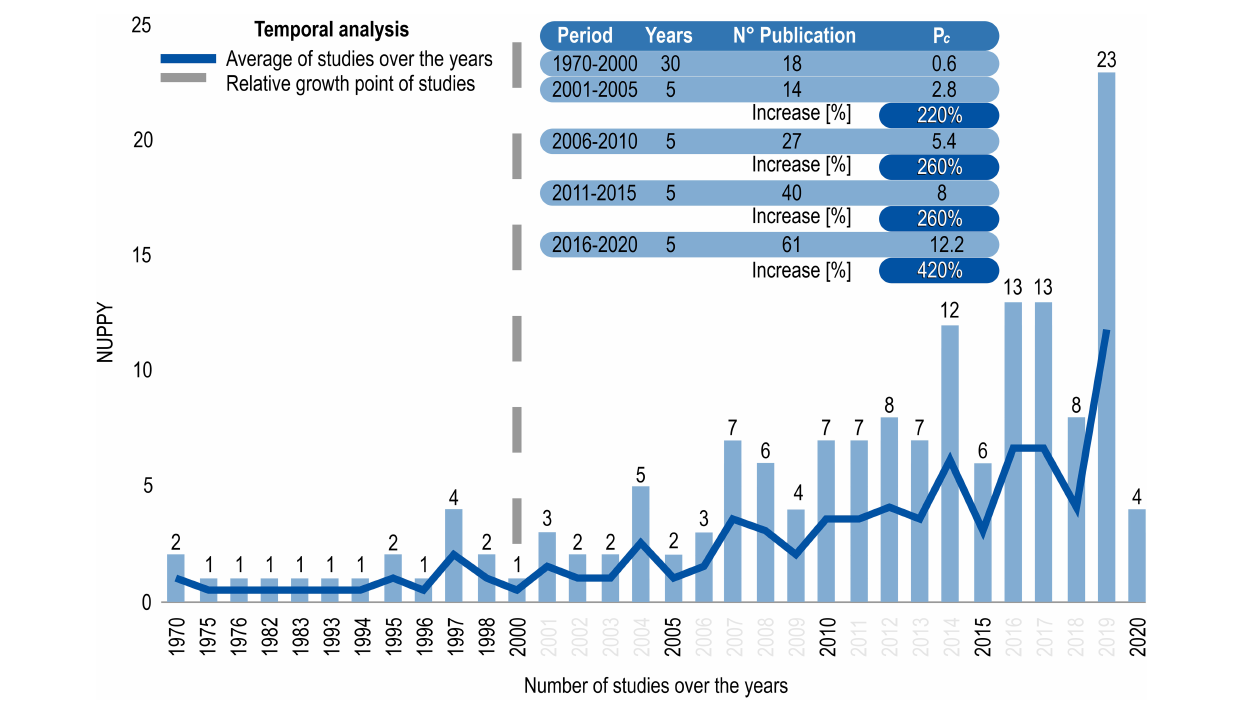
FIGURE 2 | Temporal analysis of submarine canyons studies from 1970 until April 2020 (unfinished), with an average number of studies over the years (dark blue line), and relative growth point of studies (dash gray line). The highlight for the increase of productivity coefficient ( P c ) is equal to the period analyzed divided by the